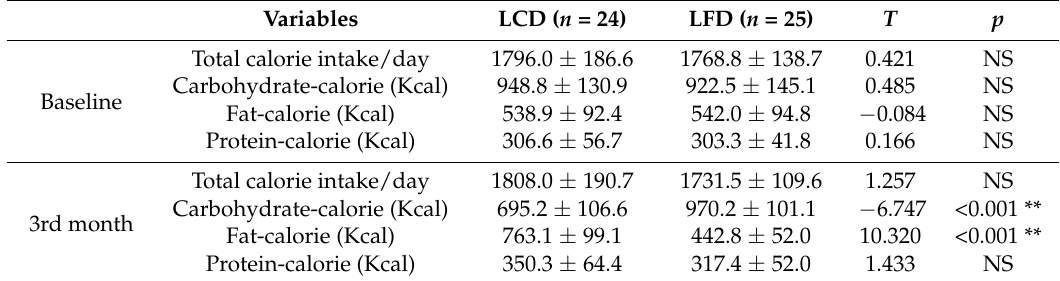
Table 3. Comparison of the calories from three macronutrients consumed by the patients.